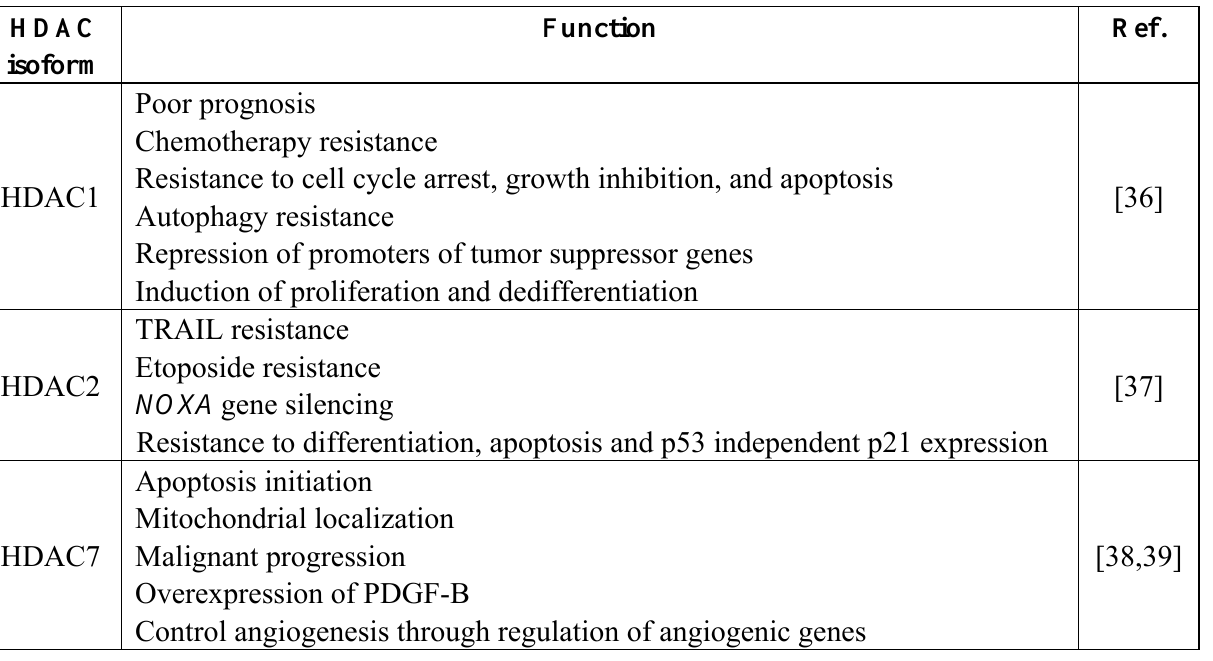
Table 2. HDAC expression in pancreatic